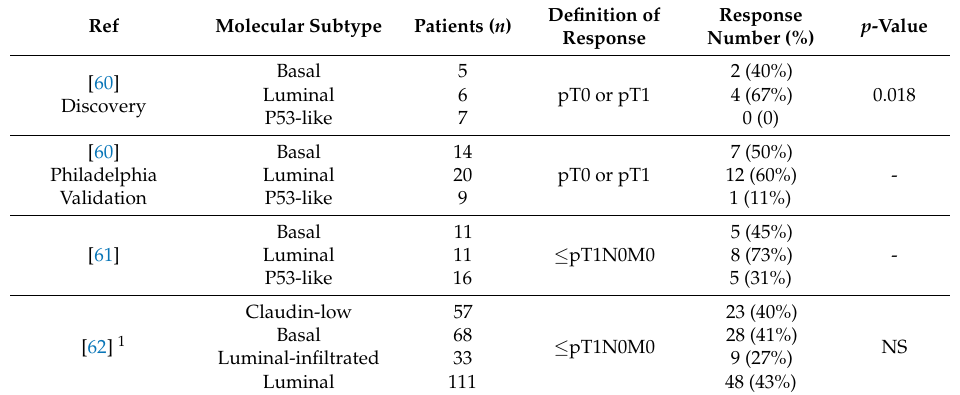
Table 2. Summary of association of molecular subtypes with response to NAC based on the published